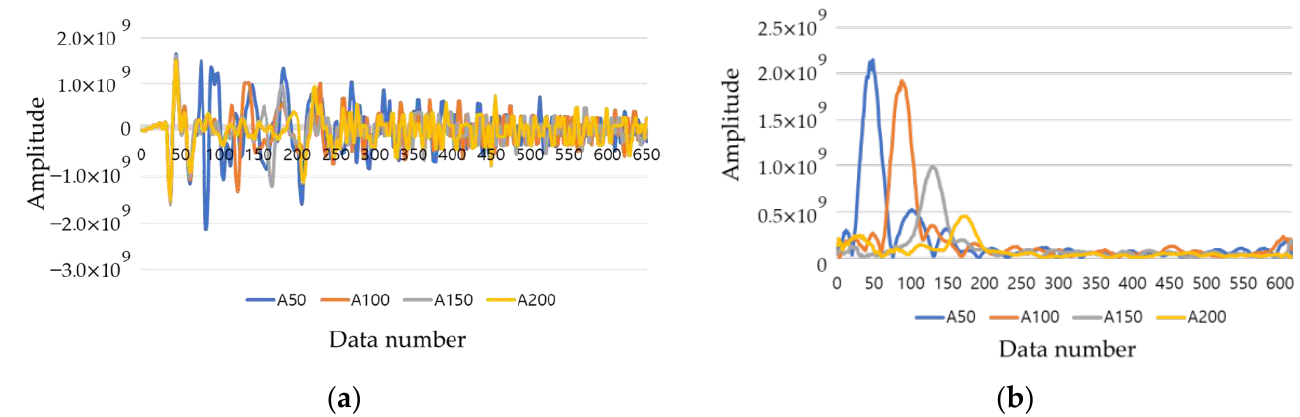
Figure 8. Raw data analysis for EM wave. ( a ) Raw data; ( b ) Hilbert transform result.